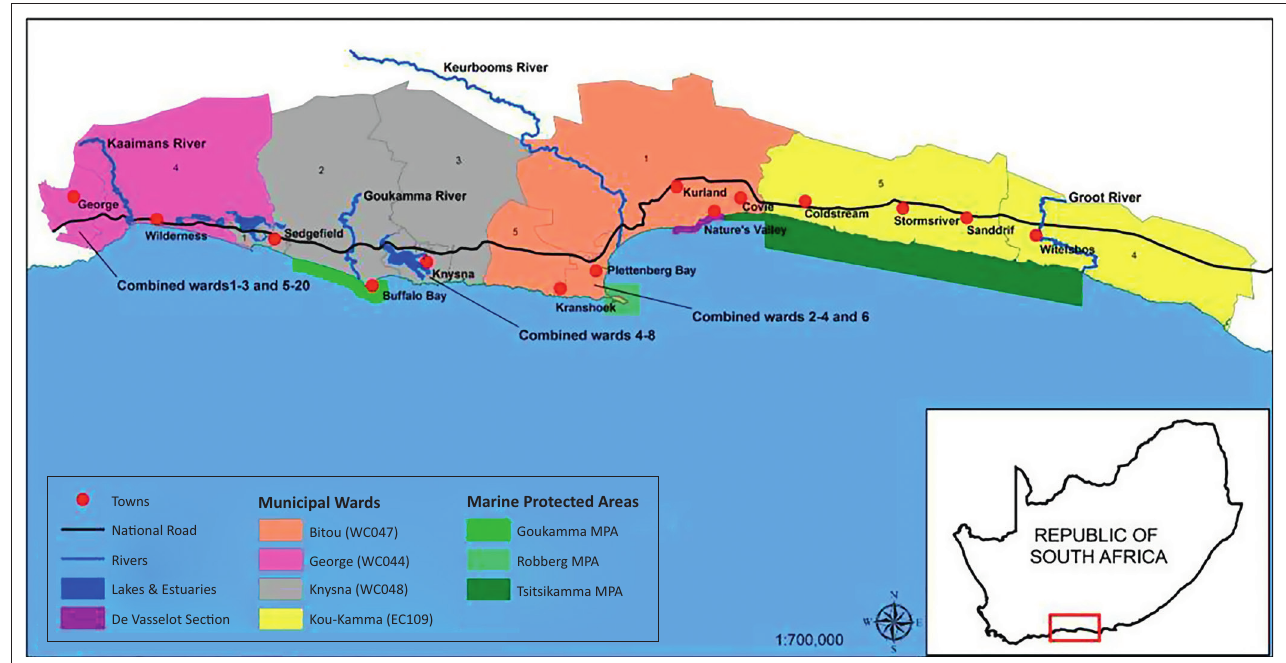
FIGURE 1: A map of South Africa showing the location of the study area along the south coast, and the location of marine protected areas, municipal wards and towns within the study area.